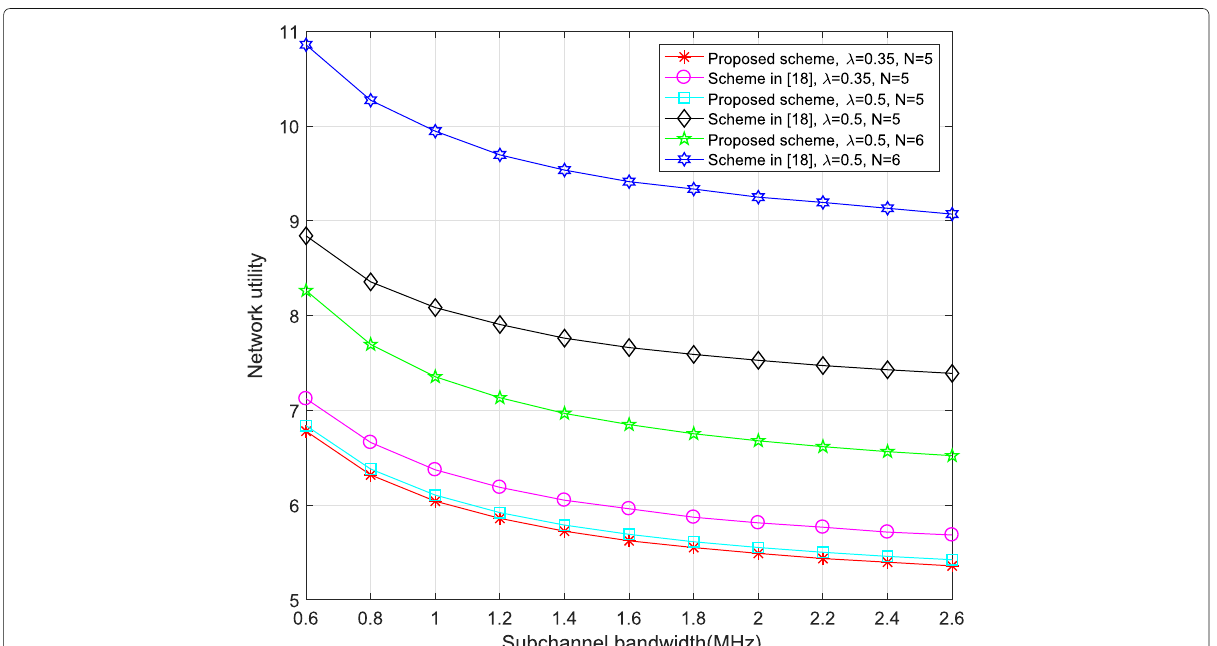
Fig. 4 Network utility versus subchannel bandwidth (different discount factor, different number of users). The network utility of the system versus the subchannel bandwidth for different discount factor and different number of users